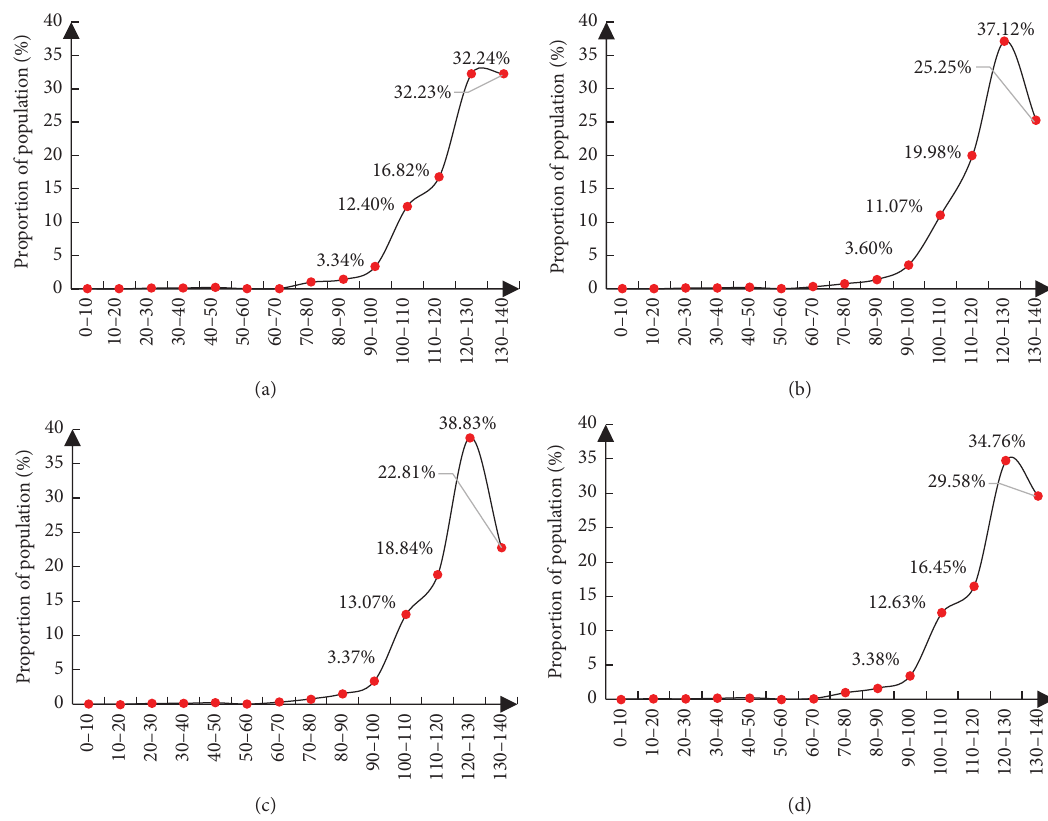
Figure 6: Number of residents for the different economic activities. (a) Employment accessibility. (b) Educational accessibility. (c) Medical accessibility. (d) Shopping and leisure accessibility. Table 2: Distributions for residents at different levels of comprehensive accessibility.